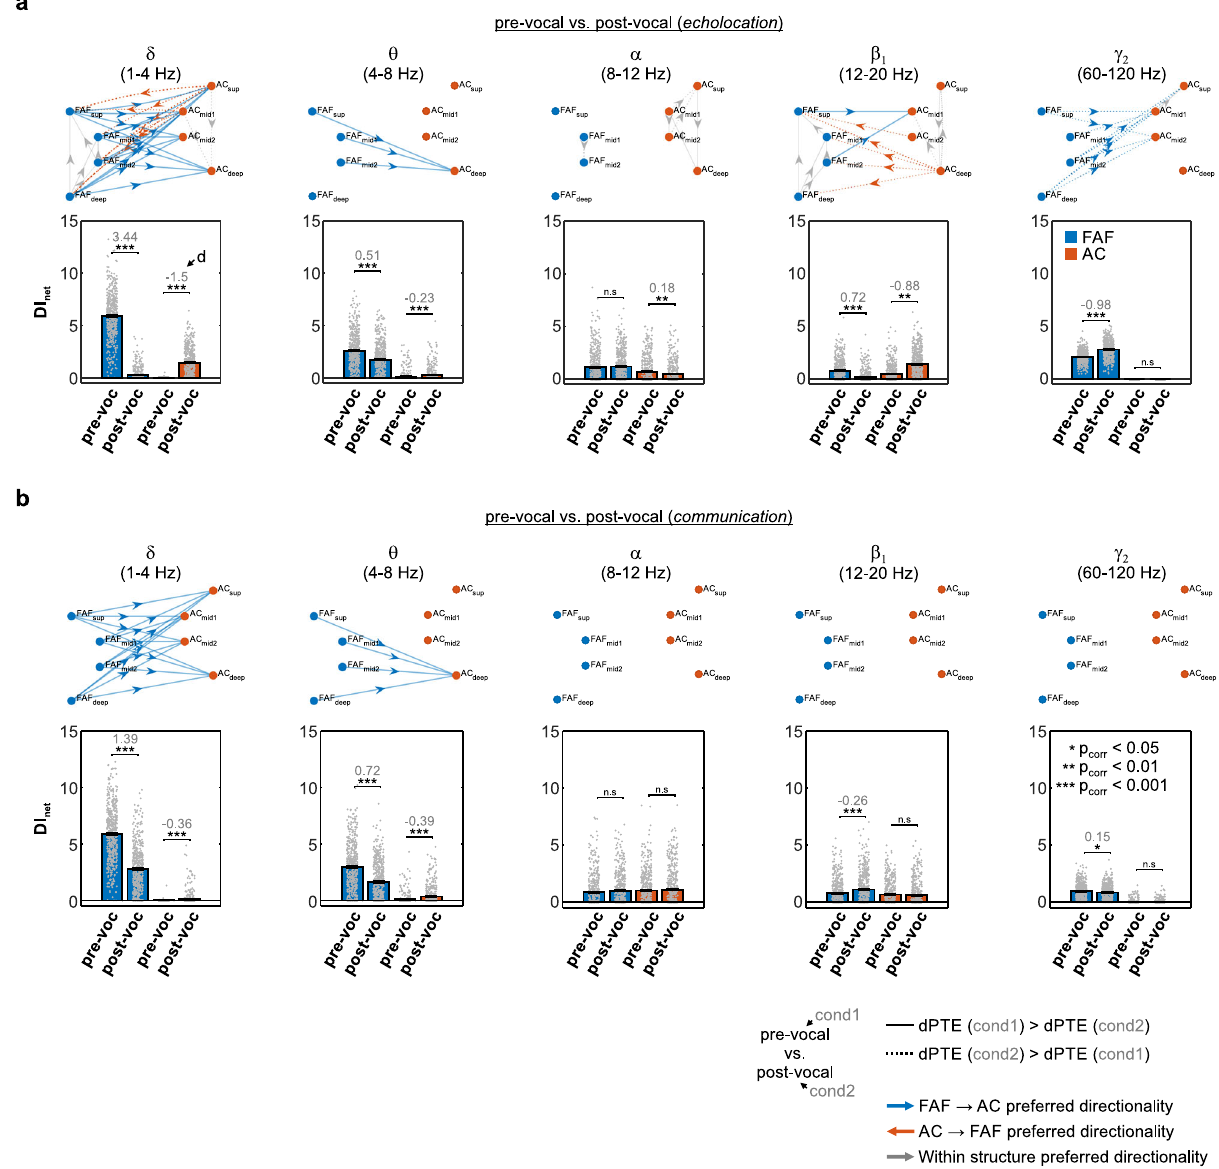
Fig. 3 Pre-vocal and post-vocal directionality differences in the FAF-AC network. a ( Top ) Graphs illustrating the differences between pre-vocal and post- vocal directionality, across frequency bands and during the production of echolocation calls. Edges were shown if three conditions were met: (i) the differences were signi fi cant (FDR-corrected Wilcoxon signed-rank tests, p corr < 0.05), (ii) the effect size was large (| d | > 0.8), and (iii) edges were already signi fi cantly directional (see edges in Fig. 2). Edge thickness is weighted according to the effect size of the comparison. Continuous lines indicate pre-vocal dPTEs ( fi rst condition) higher than post-vocal dPTEs (second condition). Dashed lines indicate the opposite. ( Bottom ) Net information out fl ow (DI net ) from FAF (blue bars) and AC (orange bars), in the two conditions considered (pre-vocal vs. post-vocal). Signi fi cant differences across conditions are marked with stars (two-sided, FDR-corrected Wilcoxon signed-rank tests; * p corr < 0.05, ** p corr < 0.01, *** p corr < 0.001, n.s.: not signi fi cant; n = 500 repetitions). Gray numbers in the panels indicate effect sizes ( d ; not shown for non-signi fi cant differences). Values were considered independently of whether there was previous signi fi cant directionality in any of the two conditions. Data shown as mean ± sem. b Same as in a , but illustrating comparisons of directionality between pre-vocal vs. post-vocal conditions related to the vocalization of communication calls. Source data are provided as a Source Data fi out fl ow (DI net ) from each area. The DI net represents the sum of and intermediate frequency bands (i.e., δ and β 1 ) of the LFP. DI values obtained from outgoing connections per region (e.g., all Speci fi cally, for the pre-vocal vs. post-vocal echolocation condi- edges in FAF related to FAF → AC connections, representing the tion (Fig. 3a, bottom), the information out fl ow from FAF was net strength of preferential information fl ow in the fronto- signi fi cantly higher in the δ band during pre-vocal periods related auditory direction). DI net values were used to statistically compare to echolocation call production ( p corr = 1.63 × 10 − 82 , d = 3.44). pre- and post-vocal periods in terms of information transfer from Notably, the net information out fl ow from AC was signi fi cantly one cortical area to another. Considering this metric, signi fi cant higher when considering post-vocal periods than pre-vocal ones differences (FDR-corrected Wilcoxon singed-rank tests, p corr < ( p corr = 3.27 × 10 − 64 , d = − 1.5). In the β 1 frequency range, there 0.05) with large effect sizes (| d | > 0.8) occurred mostly for low were no signi fi cant differences with large effect sizes between pre-